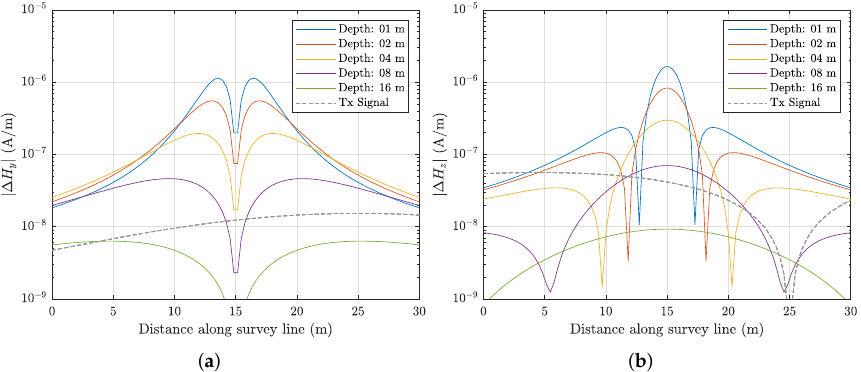
Figure 9. Model of the gradient (difference) signal as a function of depth. ( a ) | H y | response. ( b ) | H z | response.